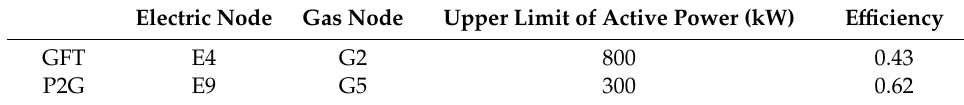
Table 6. Parameters of coupling devices.